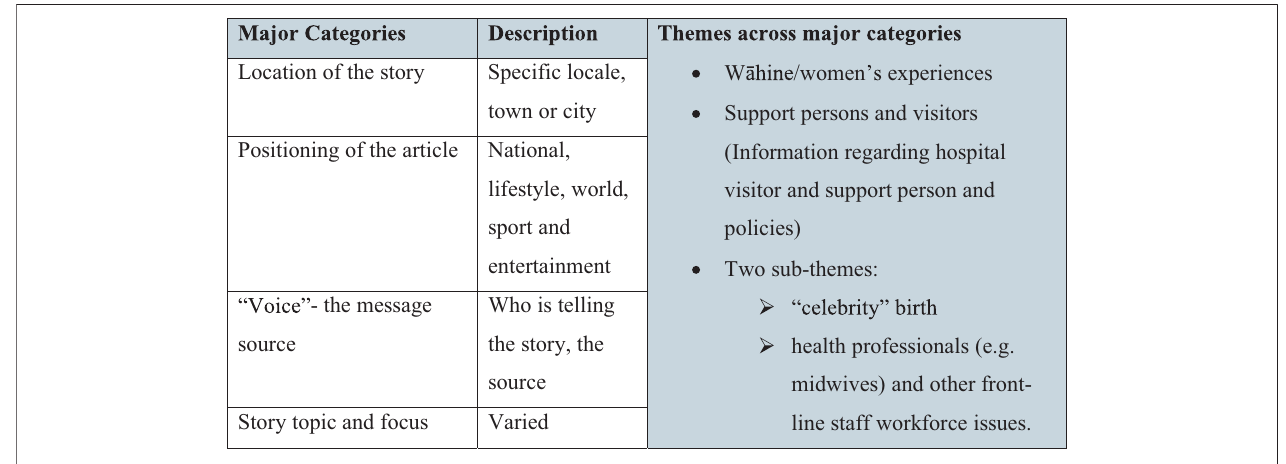
FIGURE 1 | Themes from media